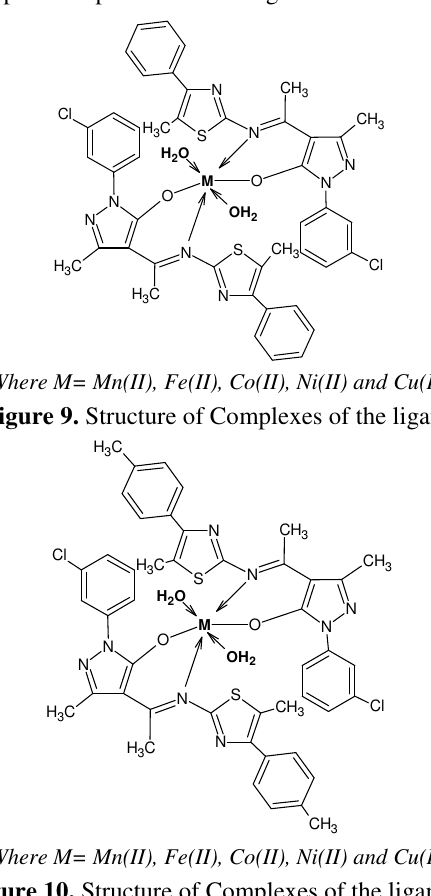
Figure 10. Structure of Complexes of the ligand